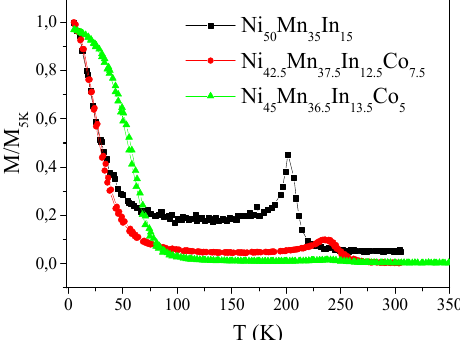
Figure 40. Temperature dependence of M/M 5K of as-prepared Ni 50 Mn 35 In 15, Ni 42.5 Mn 37.5 In 12.5 Co 7.5 and Ni 45 Mn 36.5 In 13.5 Co 5 microwires. Reproduced from reference [114], Figure 1b.